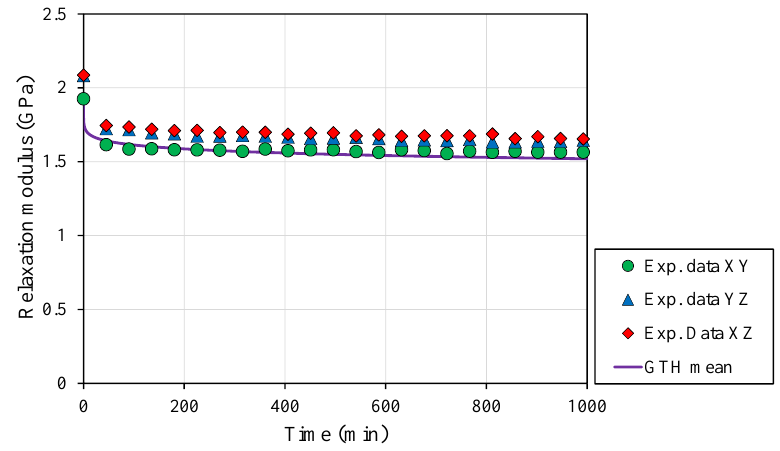
Figure 7. Stress relaxation curves for different part build orientations at RT: XY, YZ and XZ, along with the averaged GTH coefficients, proved the model’s ability to predict long time